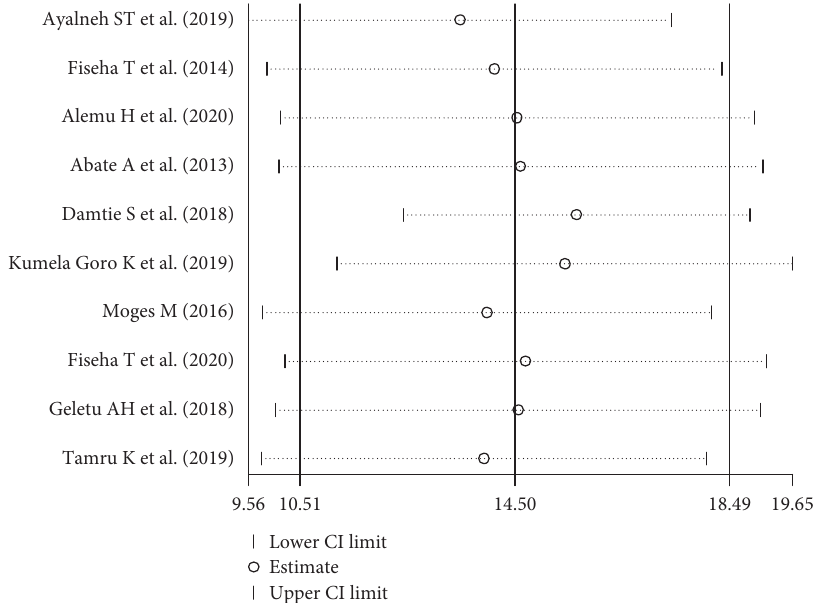
Figure 3: Results of the sensitivity analysis of the 10